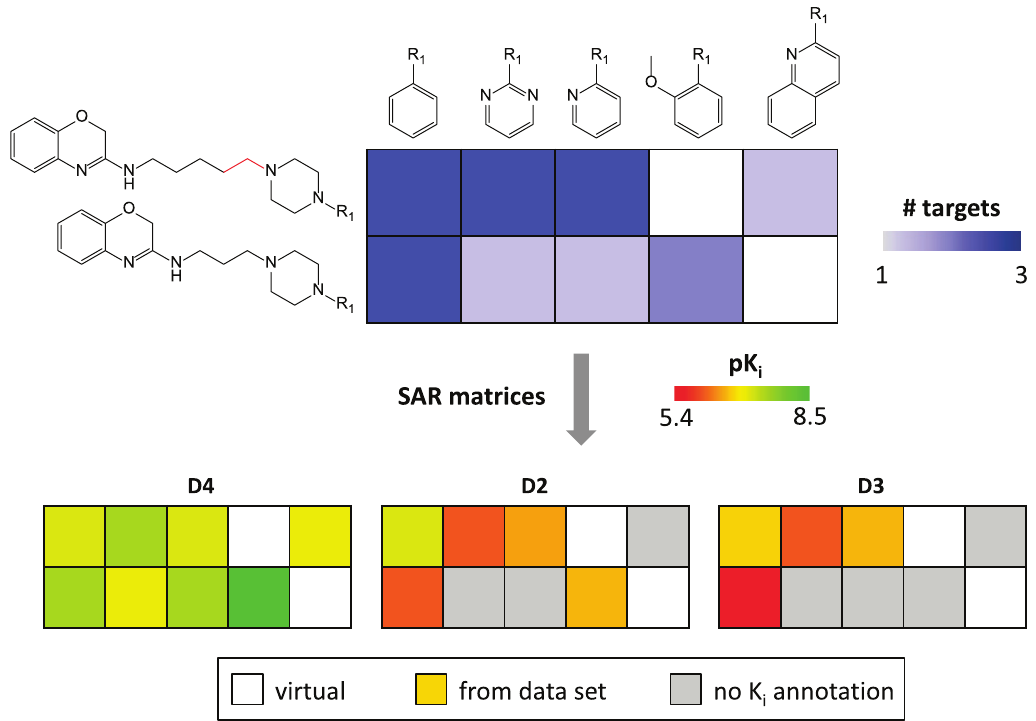
Figure 8. Matrix conversion. The deconvolution of a CSM with eight analogs active against the dopamine D2, D3, and D4 receptor isoforms into three single-target SARMs is illustrated. In all matrices, cells corresponding to VCs are not color-coded. In SARMs, cells of compounds with no available activity annotation for a given target are colored